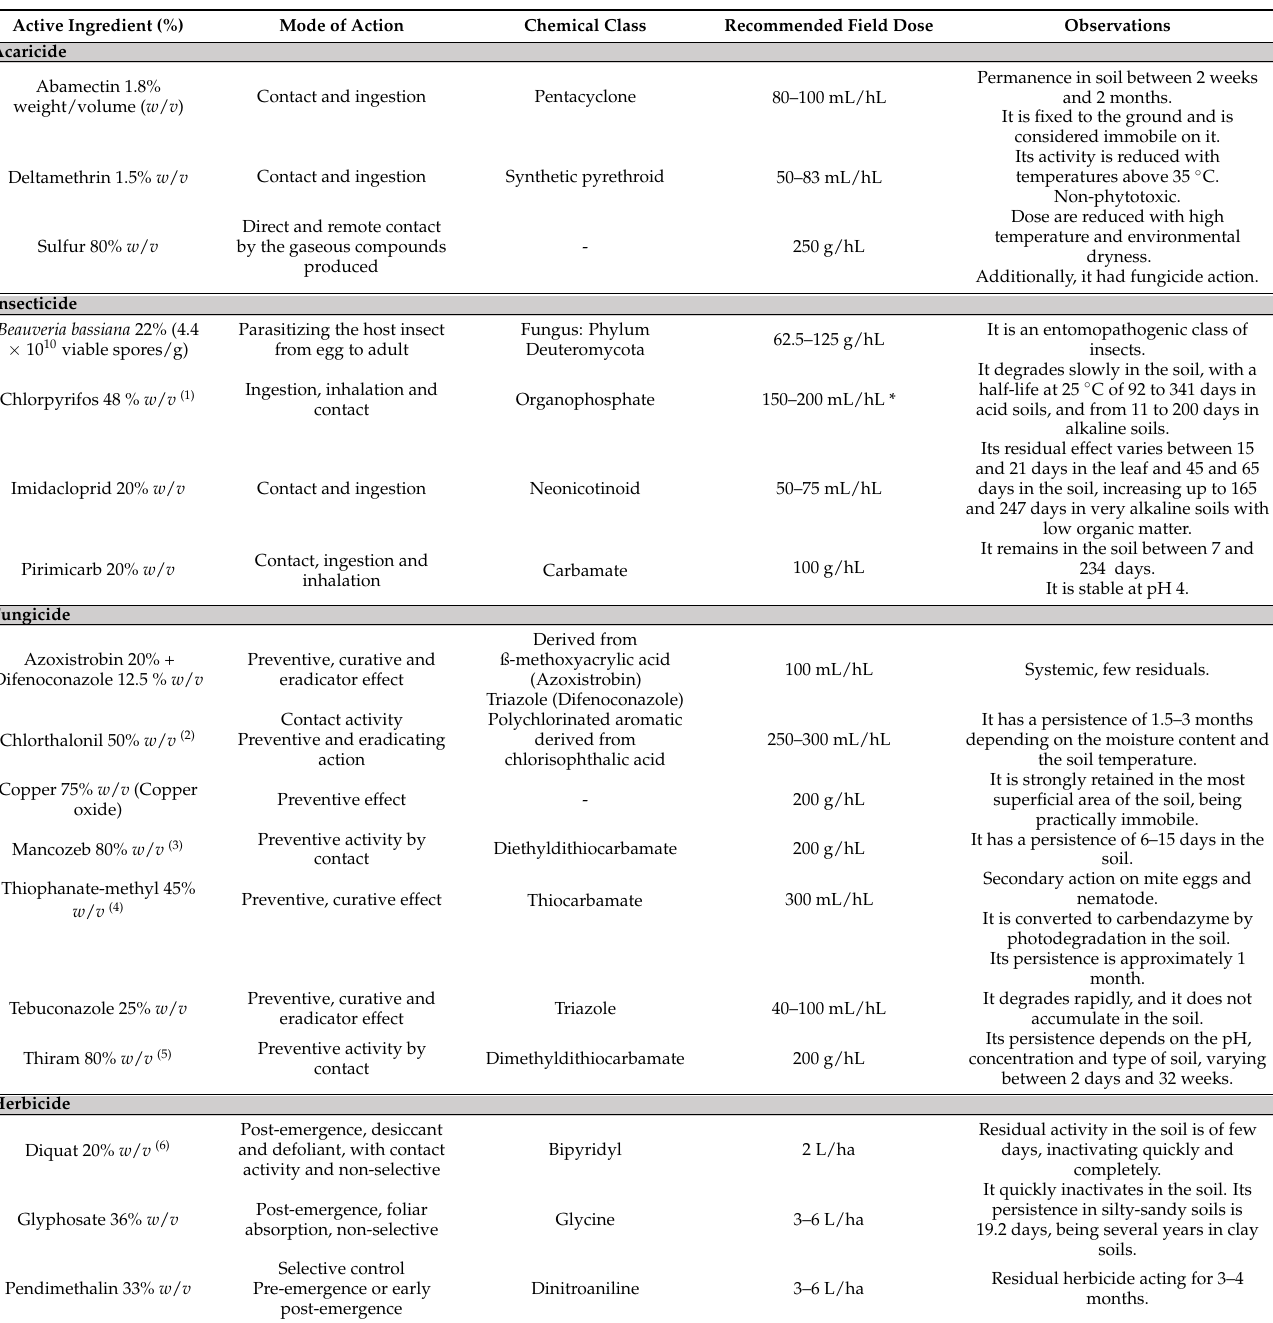
Table 2. Characteristics of phytosanitary products